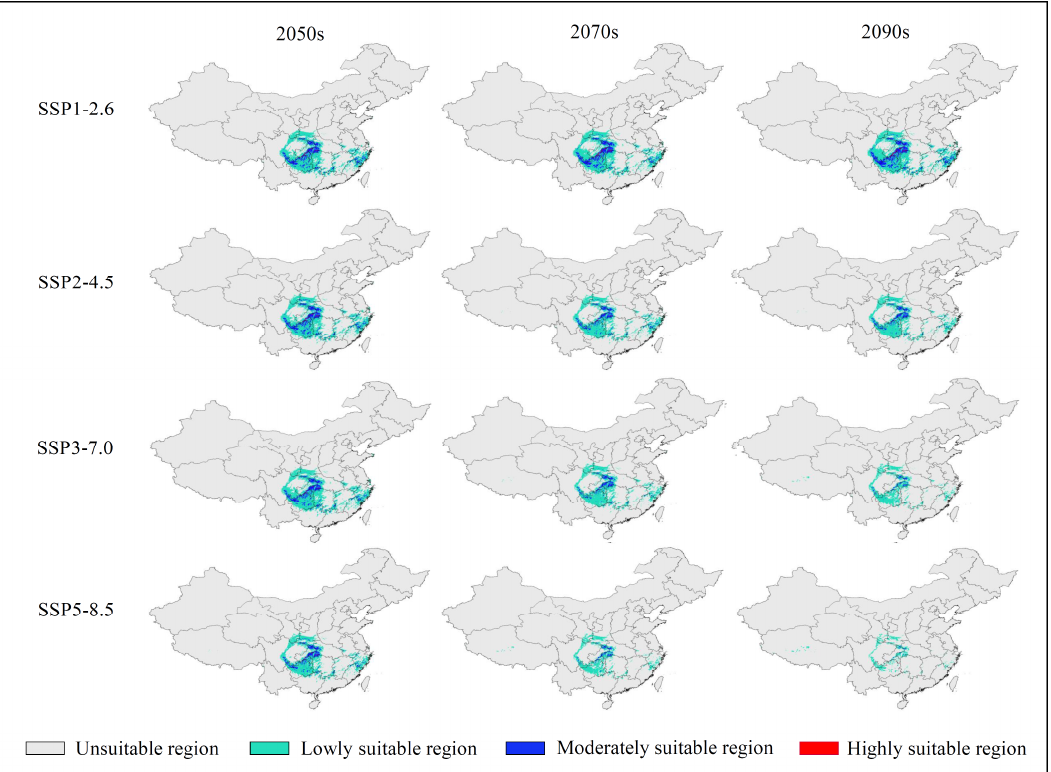
Figure 3. Predicted distribution of Coptis chinensis in China under future (2050s–2090s) climatic scenarios.